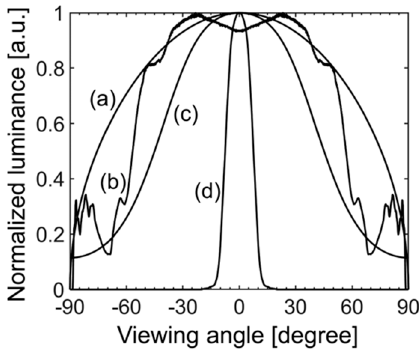
Figure 7. Normalized luminance according to the viewing angle. (a) Lambertian distribution, (b) wide-view mode of LCD system, (c) conventional IPS-LCD, and (d) narrow-view model of